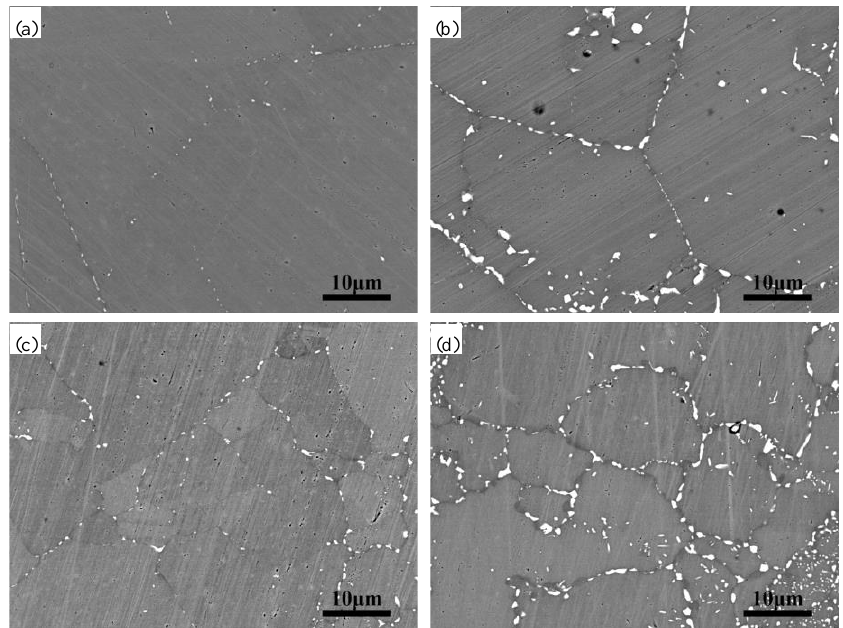
Figure 7. The backscatter images of the sensitized samples with 15% ( a , b ) and 40% ( c , d ) cold rolling reductions. ( a , c ) sensitization at 800 °C for 2 h; ( b , d ) sensitization at 800 °C for 8 h.